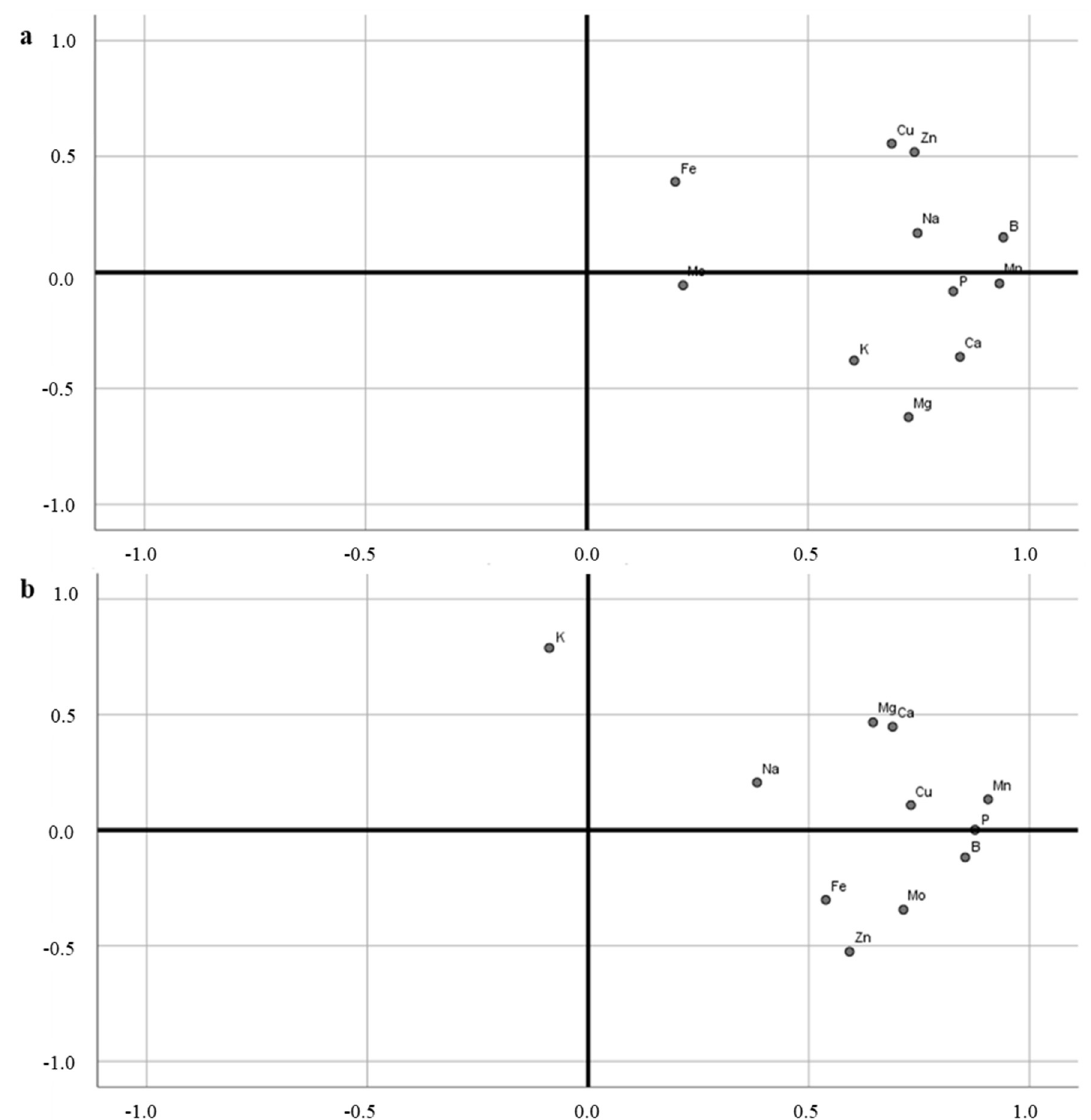
Figure 8. Principal component analysis (PCA) of pulp ( a ) and rind ( b ). Component graph in two-dimensional rotated space. Statistical analysis was performed using SPSS 25.0.0.1., including all variables in the analysis.